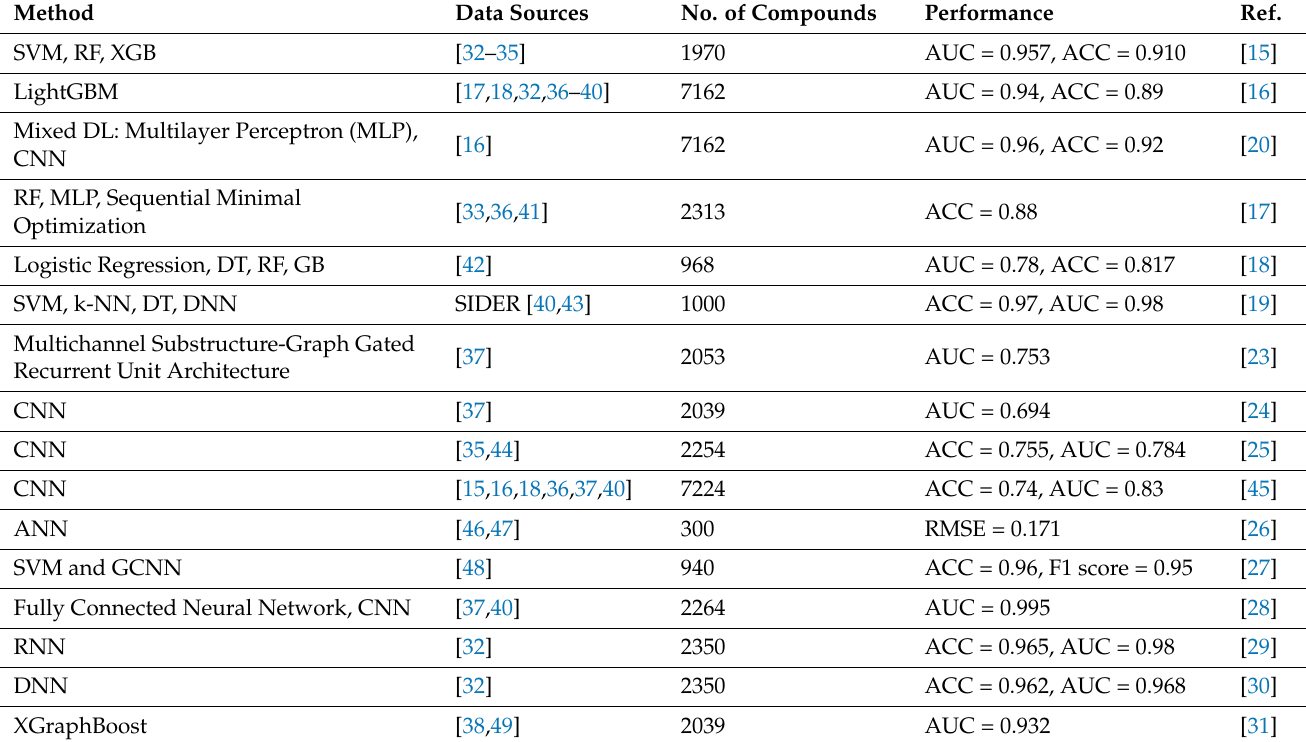
Table 1. Summary of recent AI-based studies predicting BBB